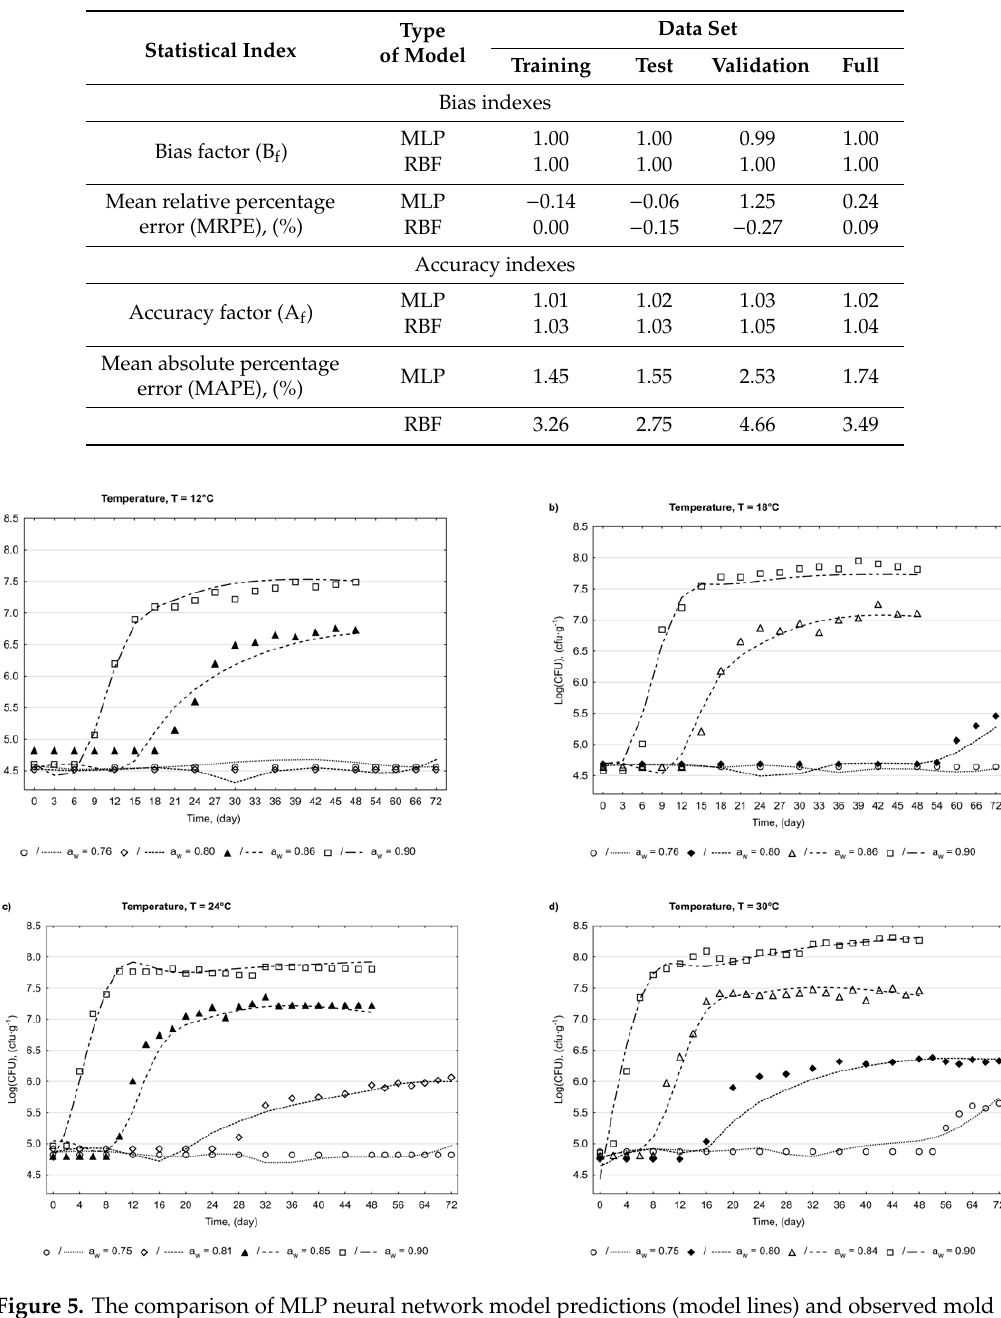
Figure 5. The comparison of MLP neural network model predictions (model lines) and observed mold Figure 5 population levels (log(CFU)) (experimental points) in rapeseed ecosystems with water activity a w = 0.75–0.90 stored at: ( a ) 12 ◦ C, ( b ) 18 ◦ C, ( c ) 24 ◦ C, ( d ) 30 ◦ C adopted from Wawrzyniak et al. [6] as a function of time (empty points – data used to model construction, filled points – validation data